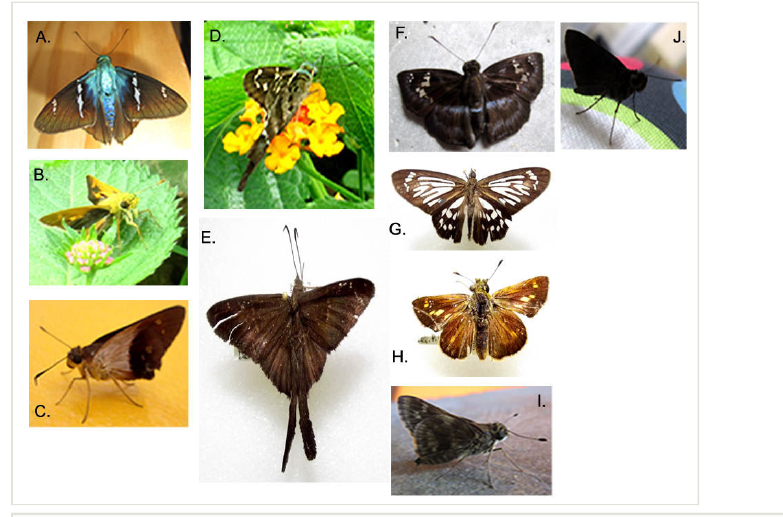
Figure 5. Hesperiidae: A) Astraptes fulgerator ; B) Anthoptus epictetus ; C) Saliana esperi ; D) Urbanus dorantes ; E) U. procne ; F) Quadrus cerialis ; G) Phanus marshalli ; H) Parphorus nr. oeagrus ; I) Pellicia arina ; J) Bolla sp.